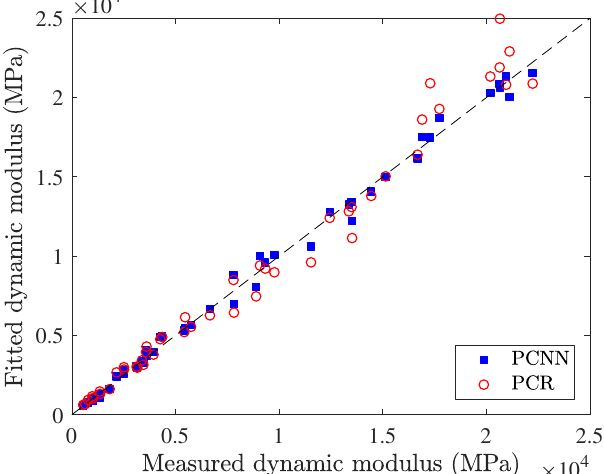
Figure 6. Measured values of dynamic modulus versus fitted values by PCR and